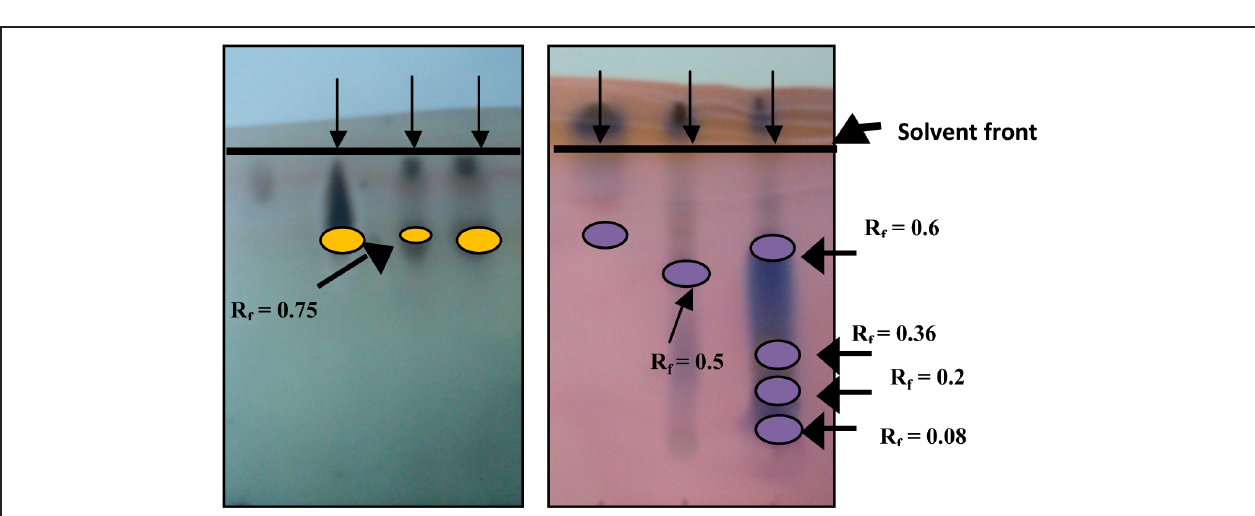
FIGURE 7 | Rhamnolipids (left) and Sophorolipids (right) TLC